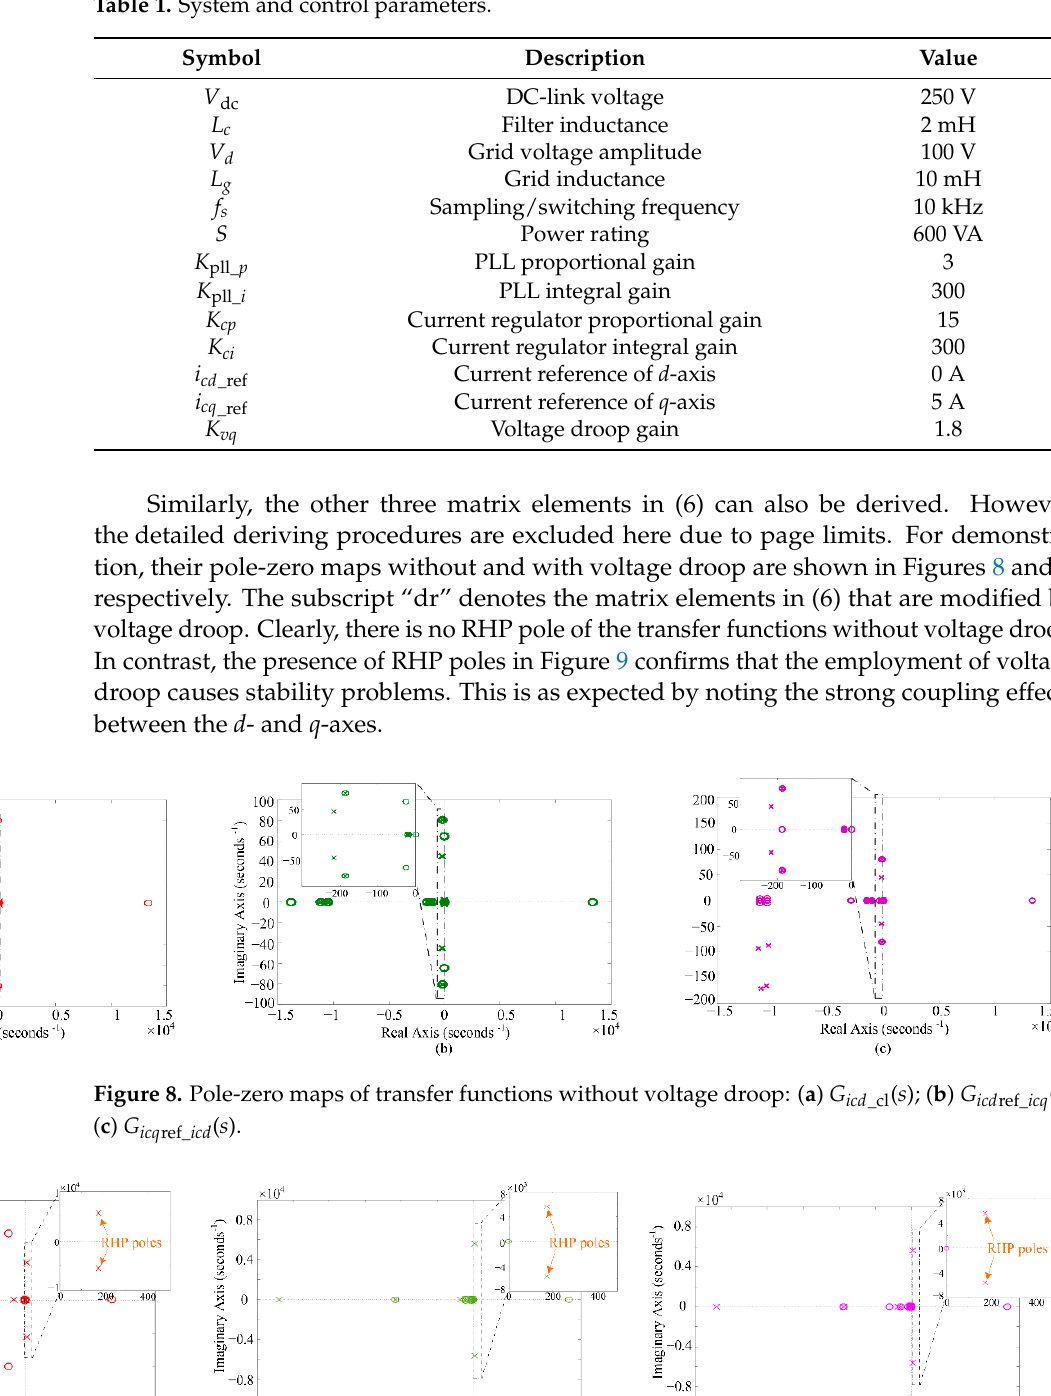
Figure 6. Pole-zero map of G icq_ cl ( s ). Table 1. System and control parameters.